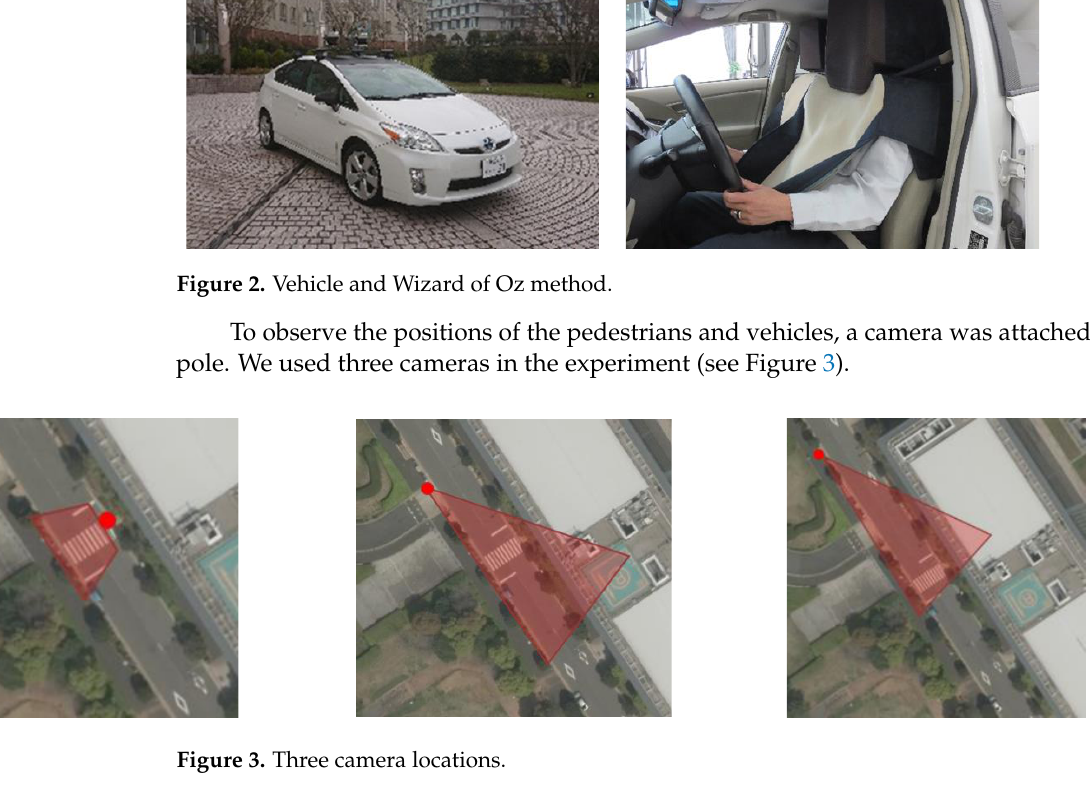
Figure 3. Three camera locations. 2.3. Positions of Pedestrian and Vehicle Using video data, the positions of the pedestrians and vehicles were recorded. We set a corner of the crosswalk as the origin (x = 0 m, y = 0 m). We recorded the coordinates of the participant’s right foot and the vehicle’s right tire every 0.5 s. Data about positions